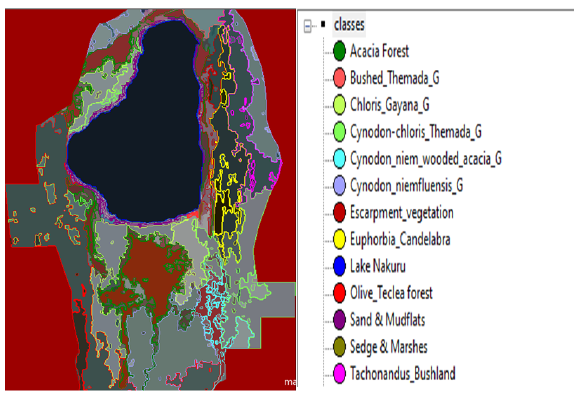
Figure 5: Landcover classification in the study area, before the onset of flooding.